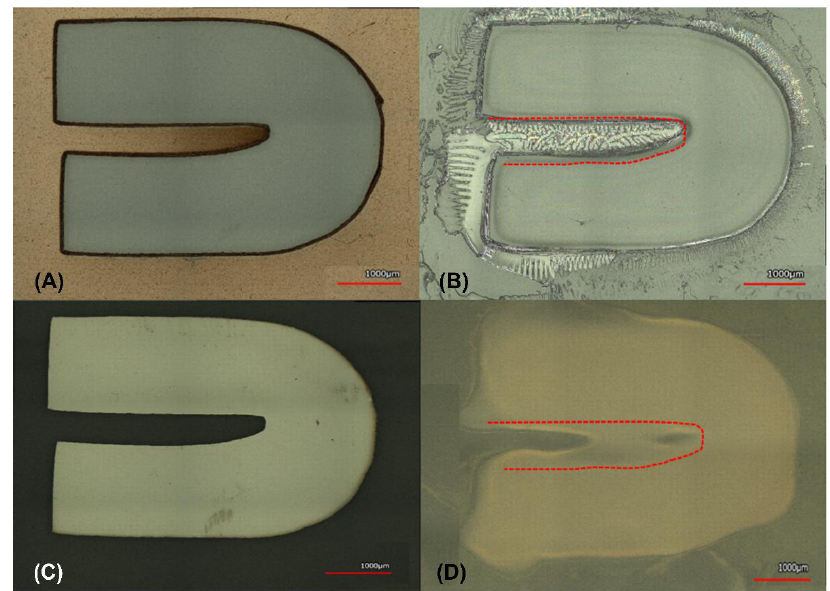
Figure 6. Serpentine Channel Depicting the Smallest feature sizes for ( A ) Stencil Mask, ( B ) Gelatin, ( C ) Cr, ( D ) E. coli .